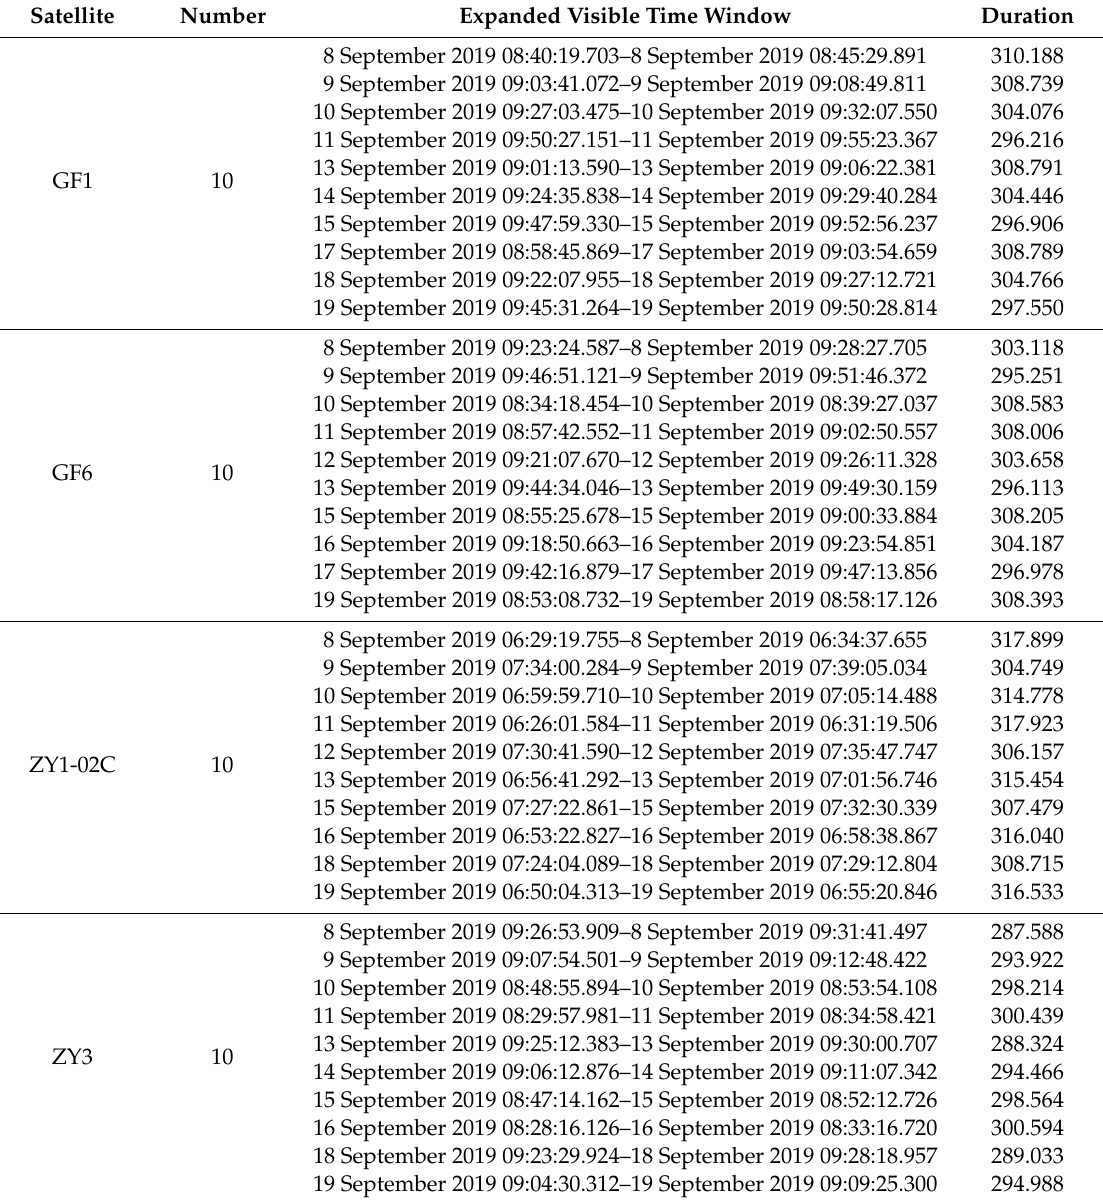
Table A3. Expanded visible time window of